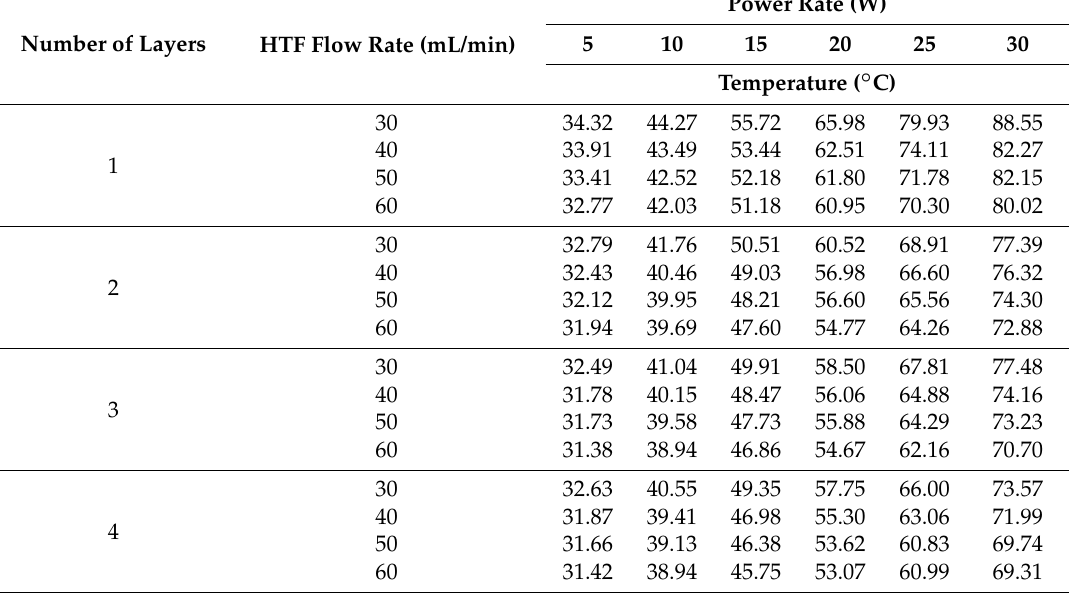
Table 8. The heat source maximum temperature for various HTF flow rates and power rates for the different layers MLM heat sinks.